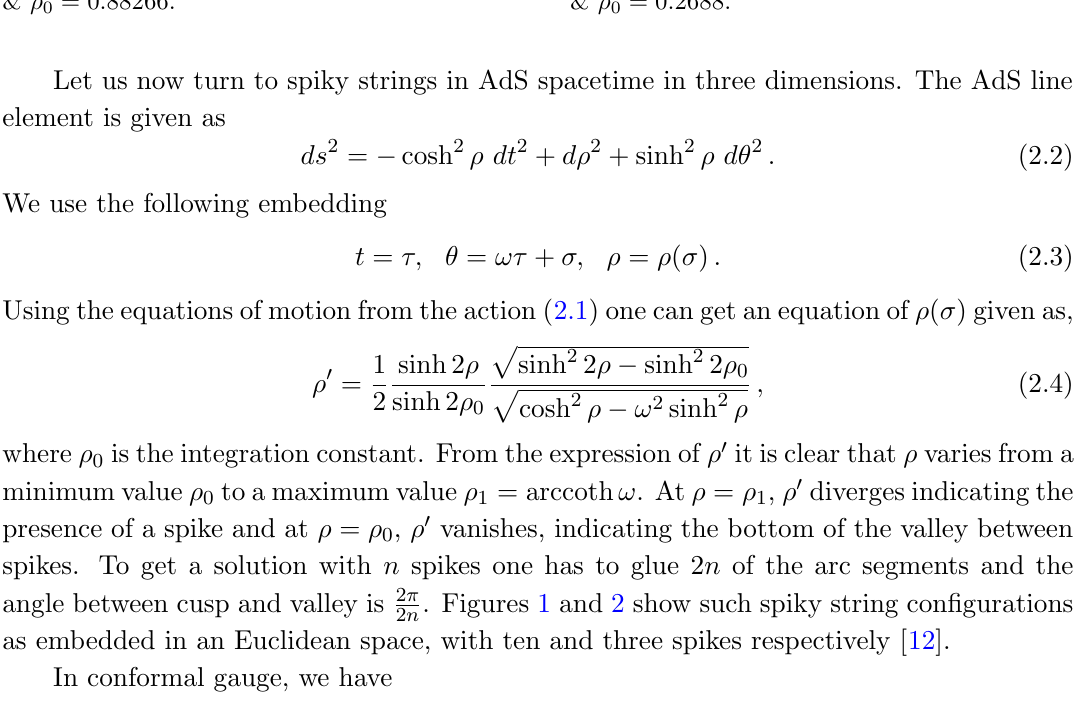
Figure 2. The Kruczenski spiky string in ( (cid:26); (cid:18) ) plane for n = 3 spikes with (cid:26) 1 = 2 : 0 & (cid:26) 0 = 0 :